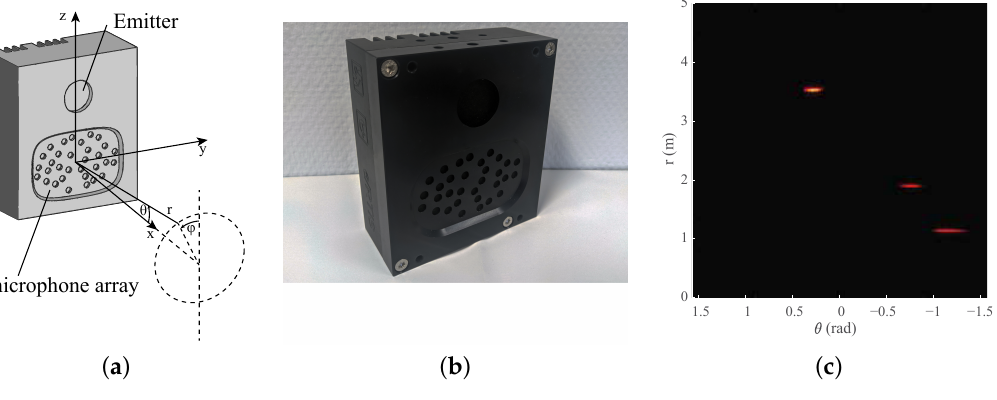
Figure 1. ( a ) The location of a reflection expressed in the spherical coordinate system ( r , θ , ϕ ) associ- ated with the sensor. The embedded real-time imaging sonar (eRTIS) sensor is drawn to show the irregularly positioned array of 32 digital microphones and the emitter. ( b ) A photo taken from the eRTIS sensor, as used in the real experiments. ( c ) An example of a 2D energyscape, a 2D sonar image of an 180° horizontal scan. Subfigures ( b , c ) were added for better visualisation of the sensor and energyscape concepts.